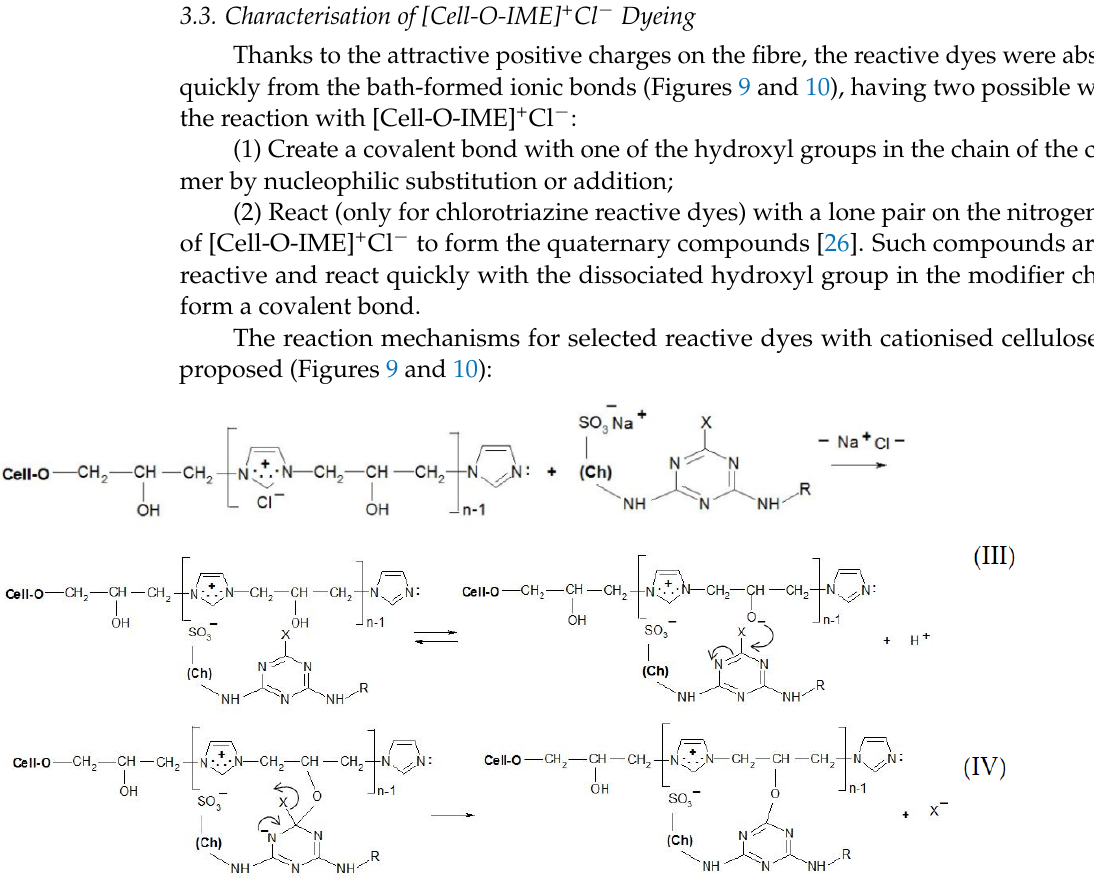
Figure 9. Proposed mechanism of the dyeing [Cell-O-IME] + Cl − with triazine dyes: ( III ) ionic formation bonds on the fibre and dissociation of a hydroxyl group in ionic pair: cationised cotton + reactive dye on the fibre, ( IV ) substitution reaction with formation of a covalent bond between reactive dye and nucleophile of the hydroksyl group where: Ch — chromophore of RR 24:1, RB 160, RR 221 and RR 274, R — different chemical substituents in the chemical structure above dyes X — nicotinic acid for RR 221, halogen for the other dyes.